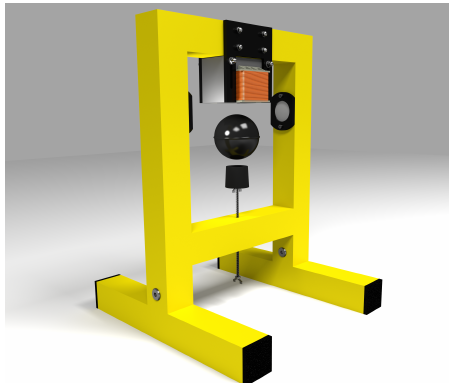
Figure 1. Laboratory magnetic levitation system used in experiments. The system is offered by INTECO [22]. The light sensor measures the degree under which the light source is covered. The electromagnet is driven by a current